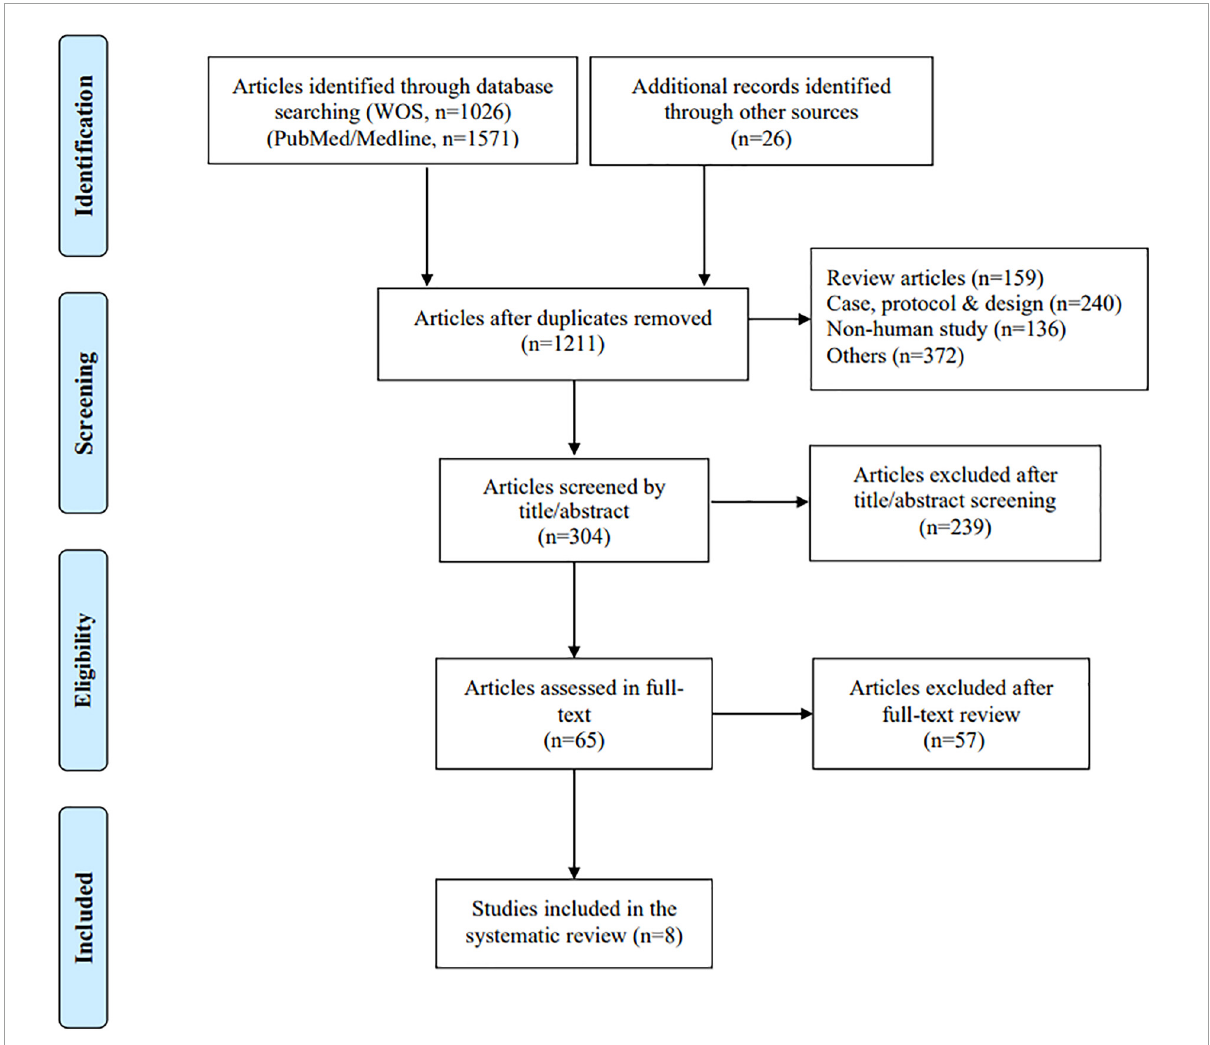
FIGURE1 PRISMA flowchart of included and excluded